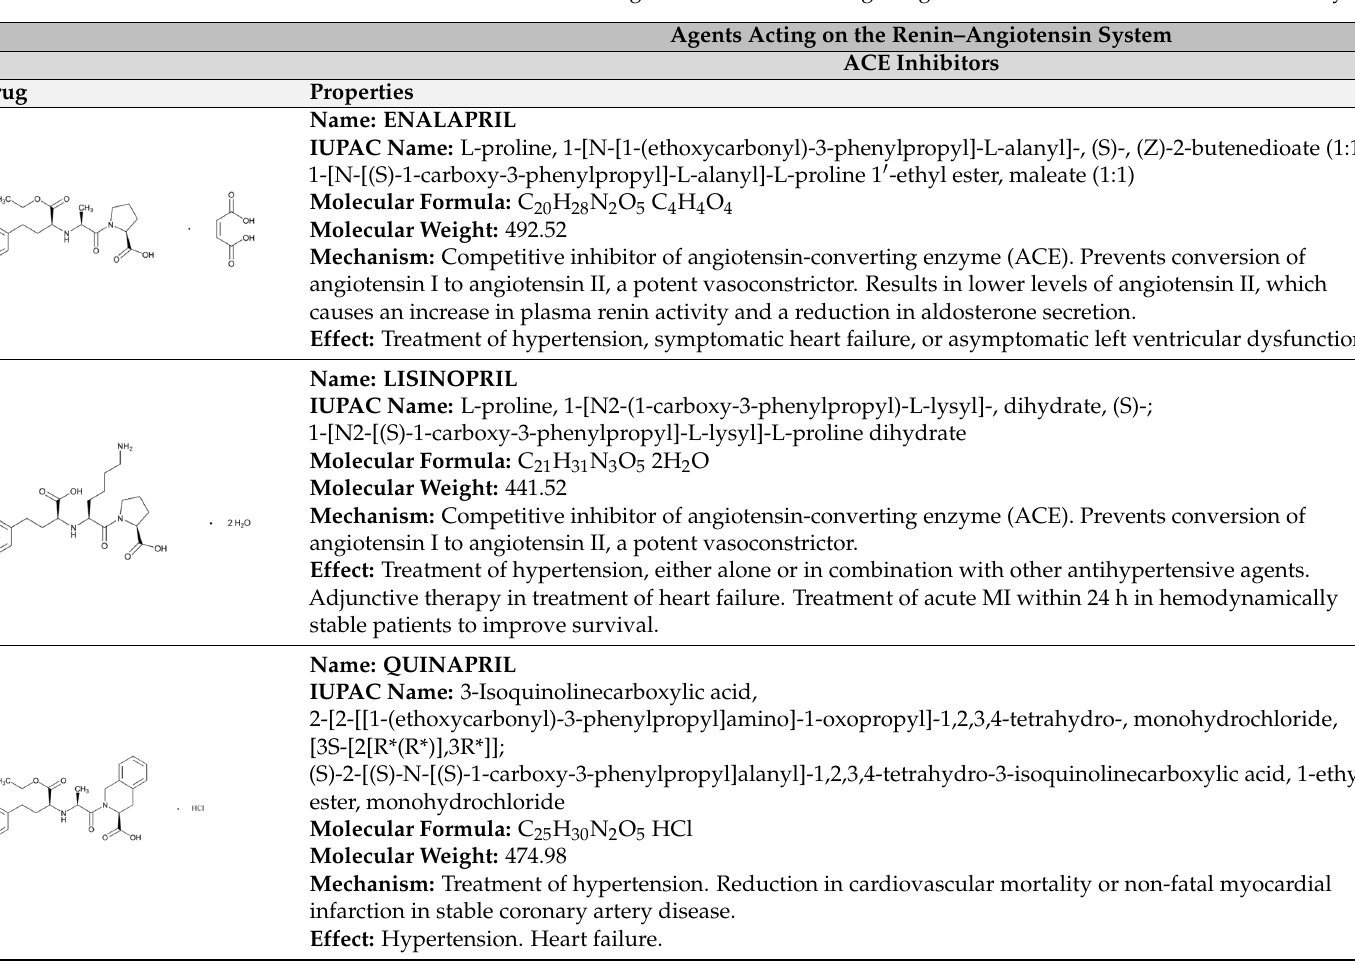
Mechanism: Treatment of hypertension. Reduction in cardiovascular mortality or non-fatal myocardial infarction in stable coronary artery disease. Effect: Hypertension. Heart